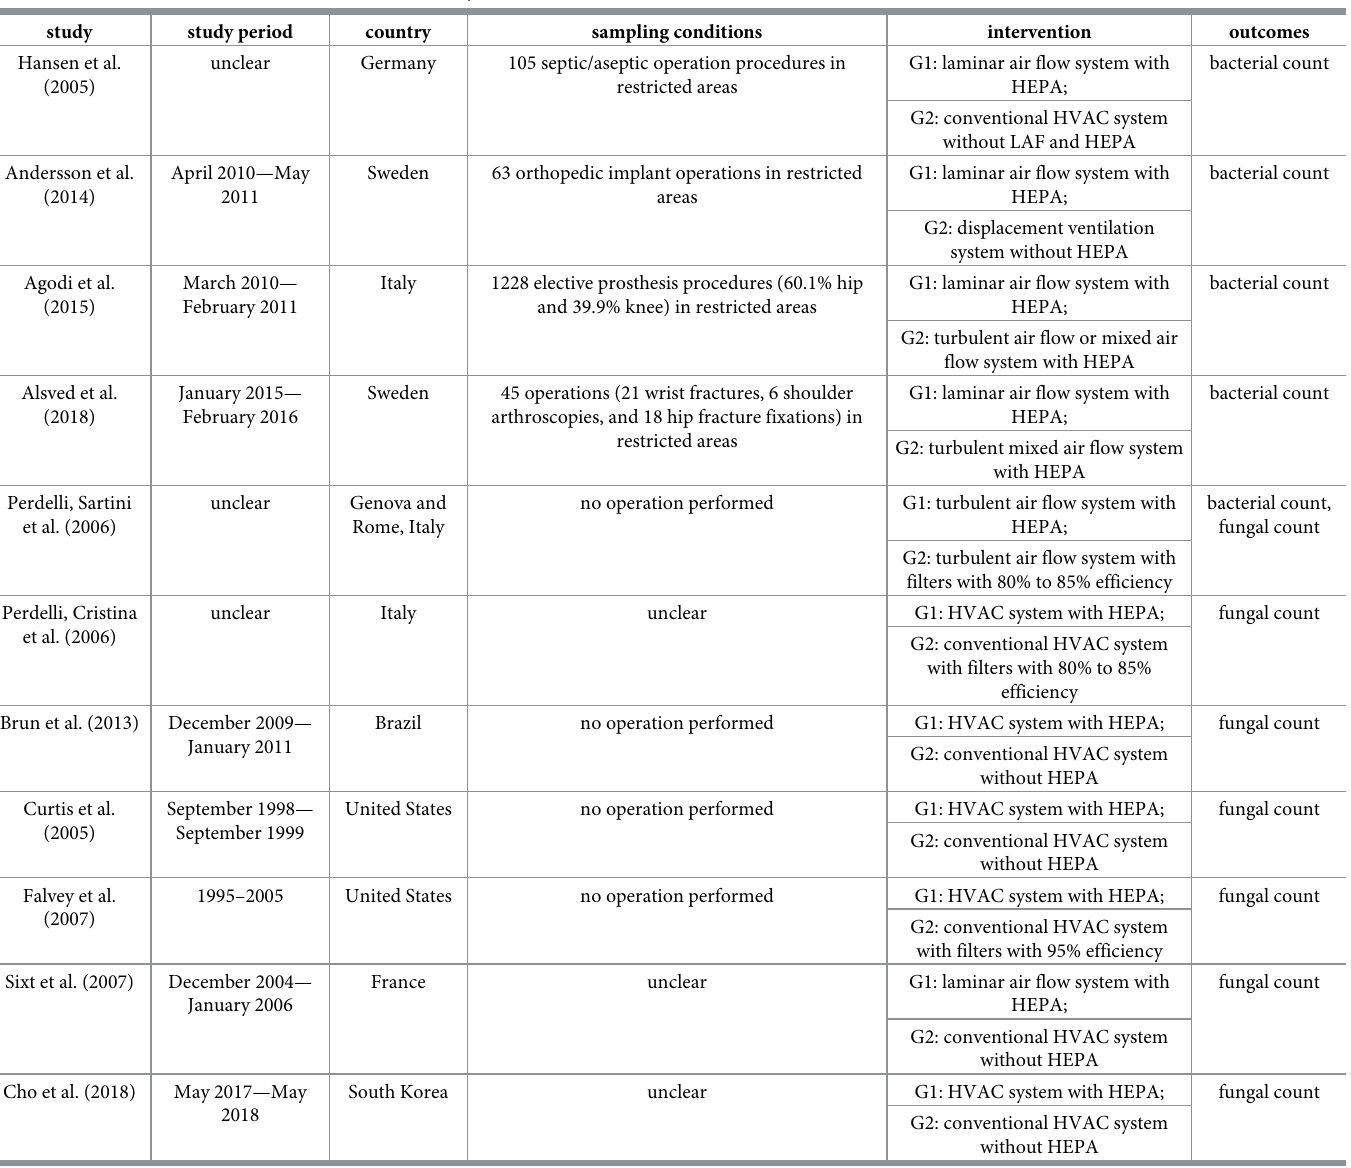
Table 2. Characteristics of Studies included in